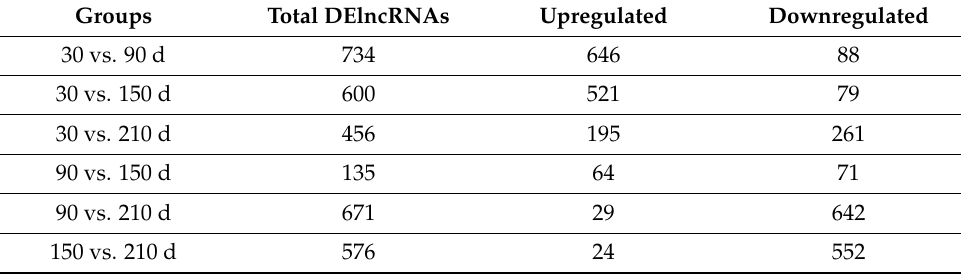
Table 5. Differential expression of